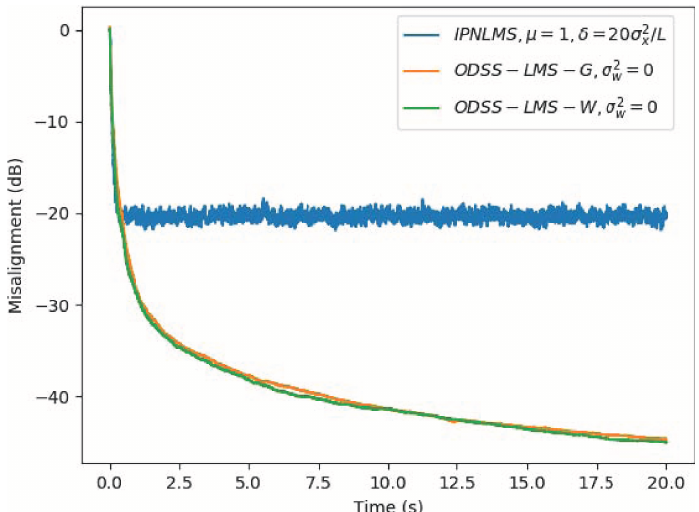
Figure 2. Normalized misalignment of the IPNLMS, ODSS-LMS-G, and ODSS-LMS-W algorithms, where σ 2 w = 0, the input signal is a white Gaussian noise, L = 512, and SNR = 20 dB. The unknown system is the acoustic echo path.